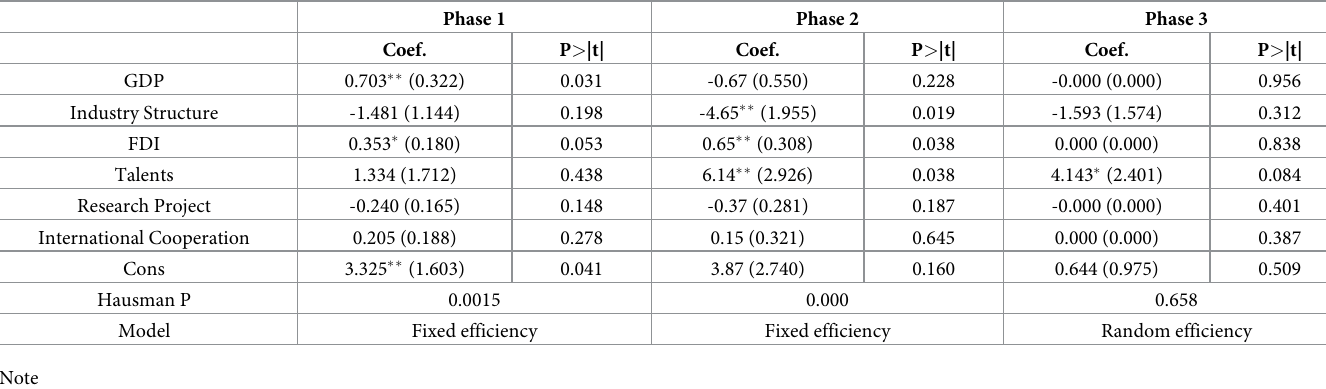
Table 3. Influence factor of university S&T transformation